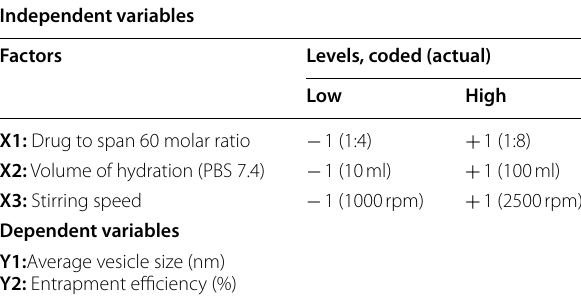
Table 1 Levels of variables in 2 3 full factorial design Independent